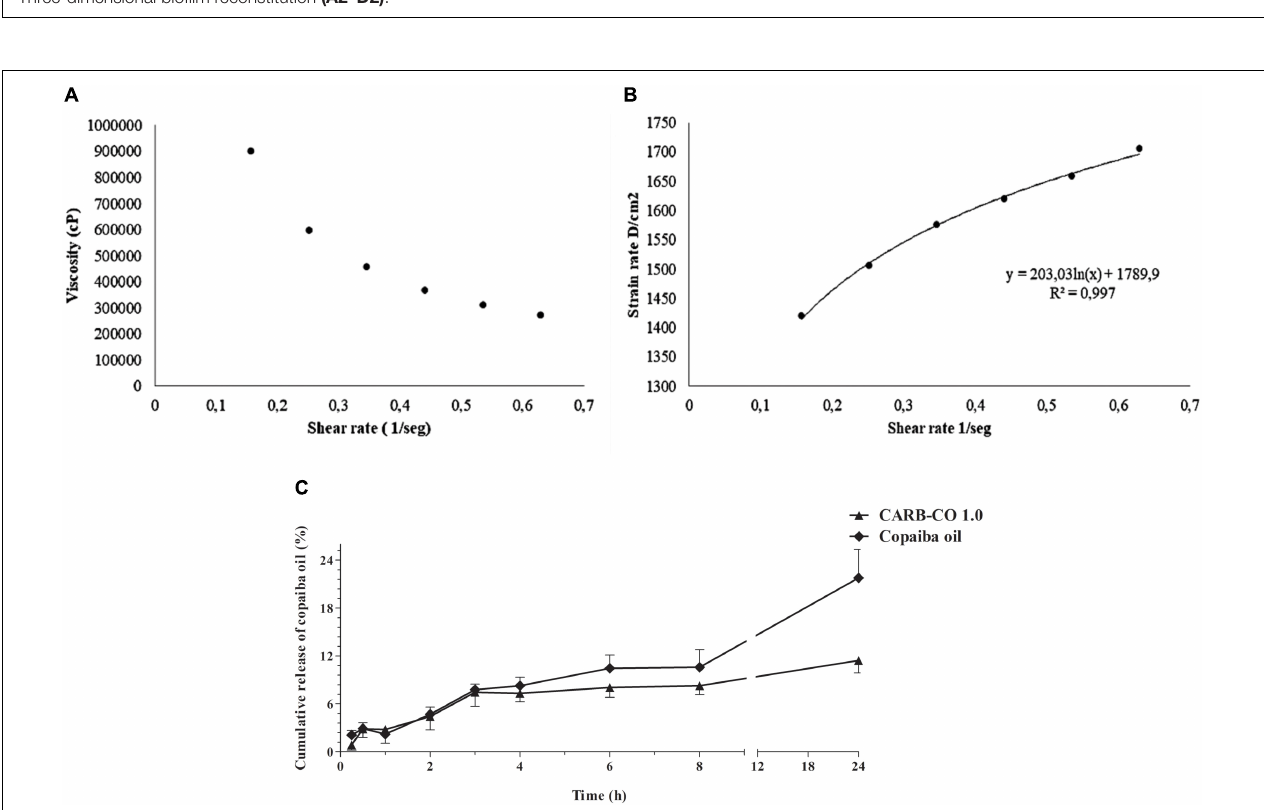
FIGURE 6 | Rheological characteristics and in vitro release of C. officinalis oleoresin loaded into CARB-CO 1.0 hydrogel. Viscosity versus shear rate of CARB-CO 1.0 (A) . CARB-CO 1.0 rheogram (B) . Time-dependent release of copaiba oil from CARB-CO 1.0 (C) .